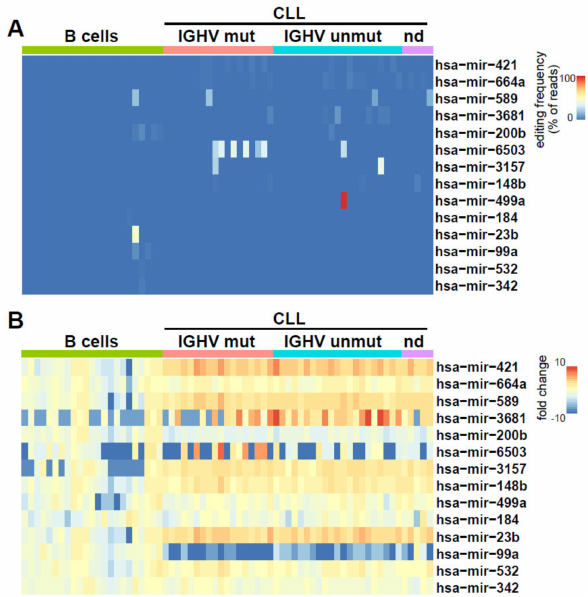
Figure 3. A to I editing in miRNAs from CLL and normal B cells. ( A ) Editing frequencies are indicated as a heat map in CLL ( n = 44) and normal B cells ( n = 23). ( B ) The heat map shows the fold change in expression in normal B cells versus CLL cells, normalized to mean expression in normal B